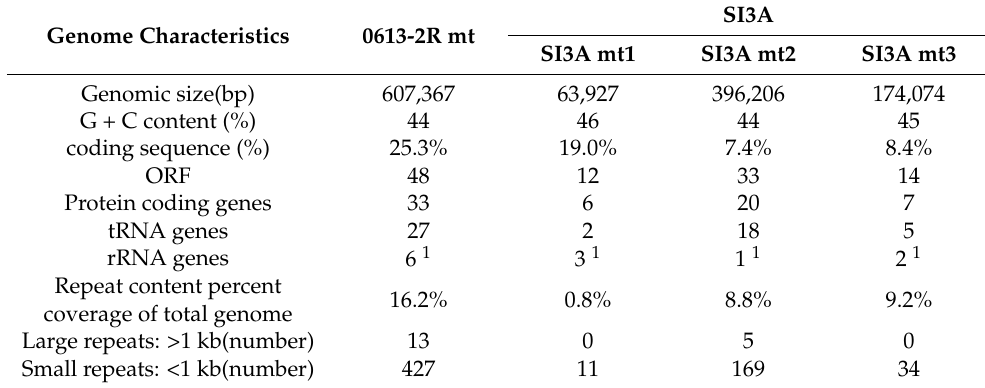
Table 1. Features of the assembly mitogenomes in the CMS line, SI3A, and its restorer line, 0-613-2R.